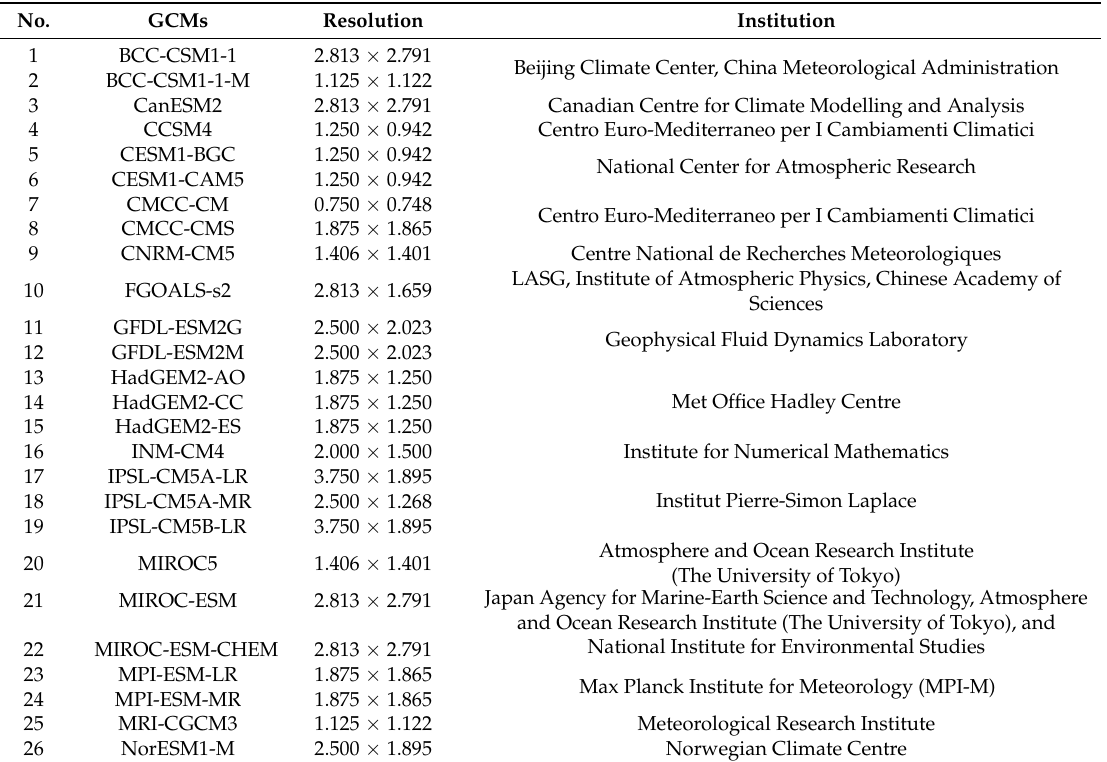
Table 1. Information of climate change